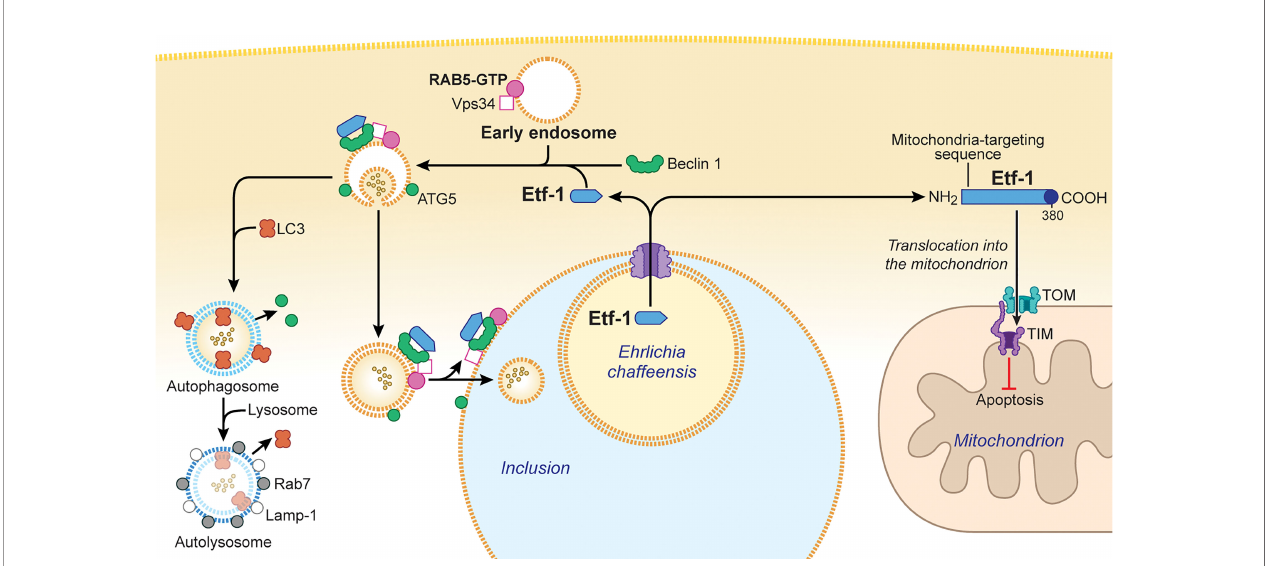
FIGURE 2 | Ehrlichia chaffeensis Etf-1 localizes to mitochondria to block apoptosis of host cells. Alternatively, Etf-1 binds to the Belin 1 – VPS34 – RAB5-GTP complex and induces RAB5-regulated autophagy. (Right) Etf-1 is depicted in blue with the putative T4SS signal depicted in dark blue. Etf-1 has a mitochondria- targeting presequence and localizes to mitochondria. Mitochondria-localized Etf-1 blocks apoptosis of eukaryotic host cells by preventing loss of mitochondrial membrane potential. TOM: transporter outer membrane complex; TIM: transporter inner membrane complex. (Left) Etf-1 binds the Beclin 1 – VPS34 – RAB5-GTP complex and induces RAB5-regualted autophagy. Etf-1 autophagosomes are recruited to E. chaffeensis inclusions and deliver captured host cytoplasmic contents. If not recruited to inclusions, Etf-1 autophagosomes mature to autolysosomes, in which captured substrates are degraded and catabolites are released to the cytoplasmic to promote bacterial proliferation. The drawing was modi fi ed from (Rikihisa, 2019), copyright 2017 Taylor & Francis, and from (Rikihisa, 2017), copyright 2017